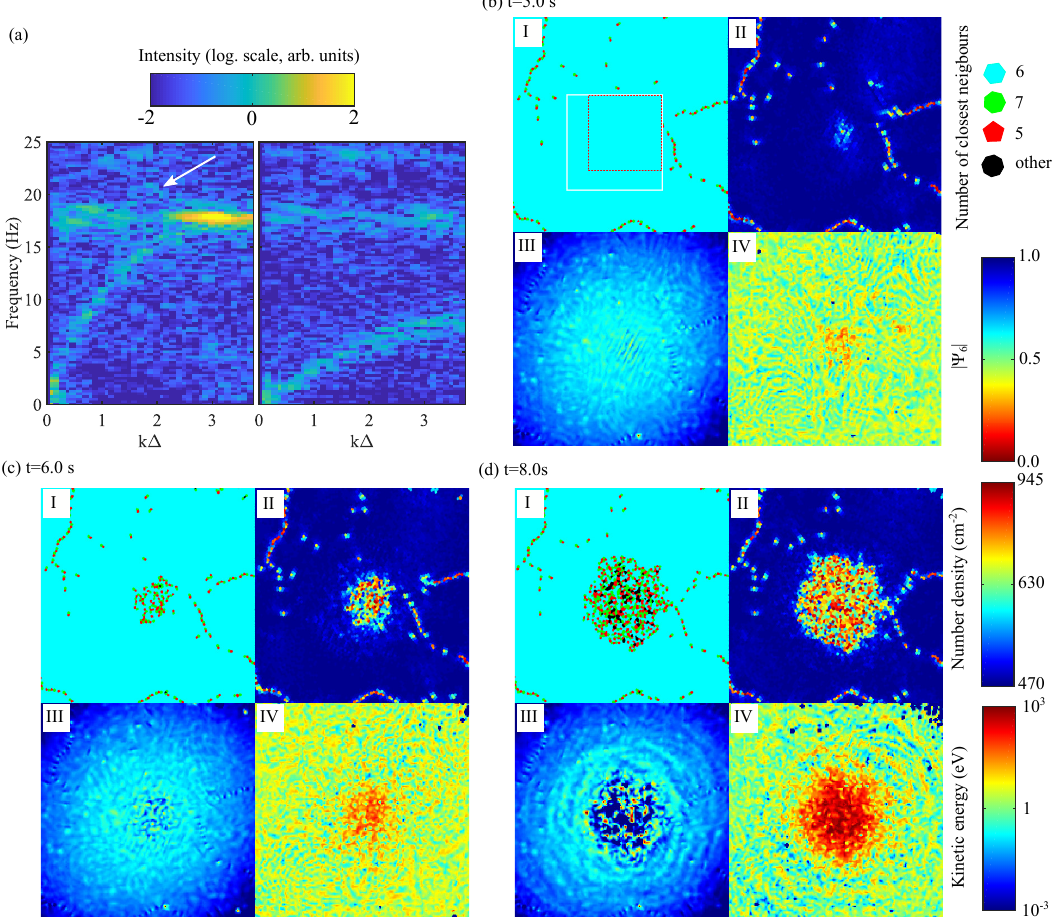
Figure 6. ( a ) Longitudinal (left) and transverse (right) current fluctuation spectra of the monolayer in the crystalline state for θ = 0 ◦ . The arrow shows the traces of mixed polarisation. ( b ) Monolayer at t = 5.0 s. ( c ) Monolayer at t = 6.0 s. ( d ) Monolayer at t = 8.0 s. In ( b – d ), I shows the map of defects. The number of closest neighbours is colour-coded; II shows the value of the bond orientational order | ψ 6 | ; III shows the particle number density; IV shows the particle kinetic energy (global drift is not removed). In ( b )I, the white square shows the area used to compute the current fluctuation spectra shown in ( a ), and the red square shows the area used for computing the evolution of the kinetic temperature shown in Figure